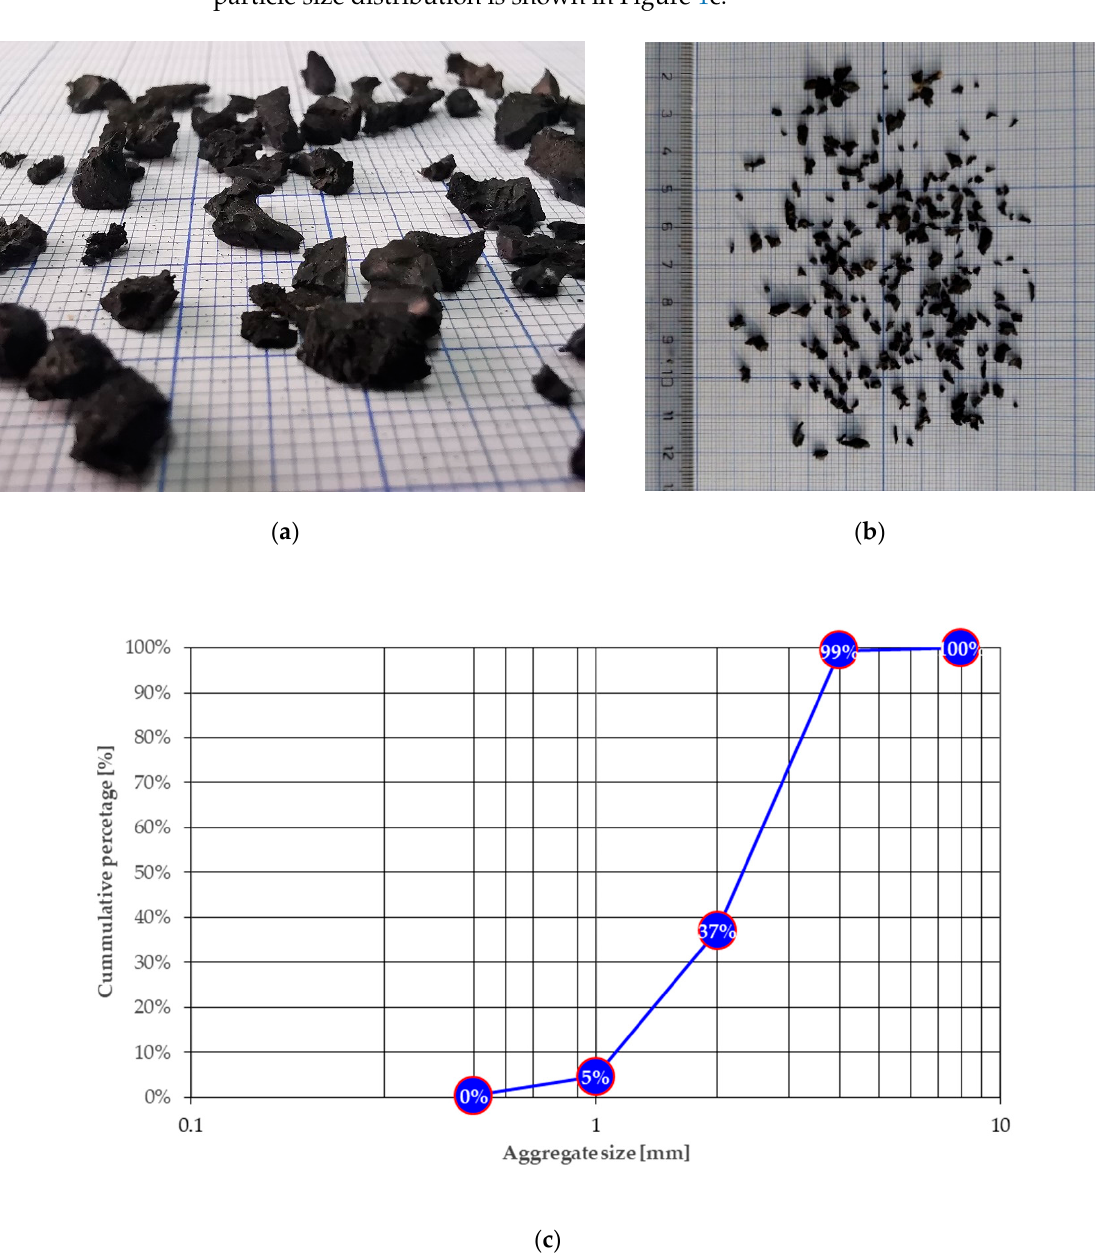
Figure 1. Rubber aggregates from worn tyres. ( a ) Surface texture; ( b ) Rubber aggregates; ( c ) Particle size distribution.